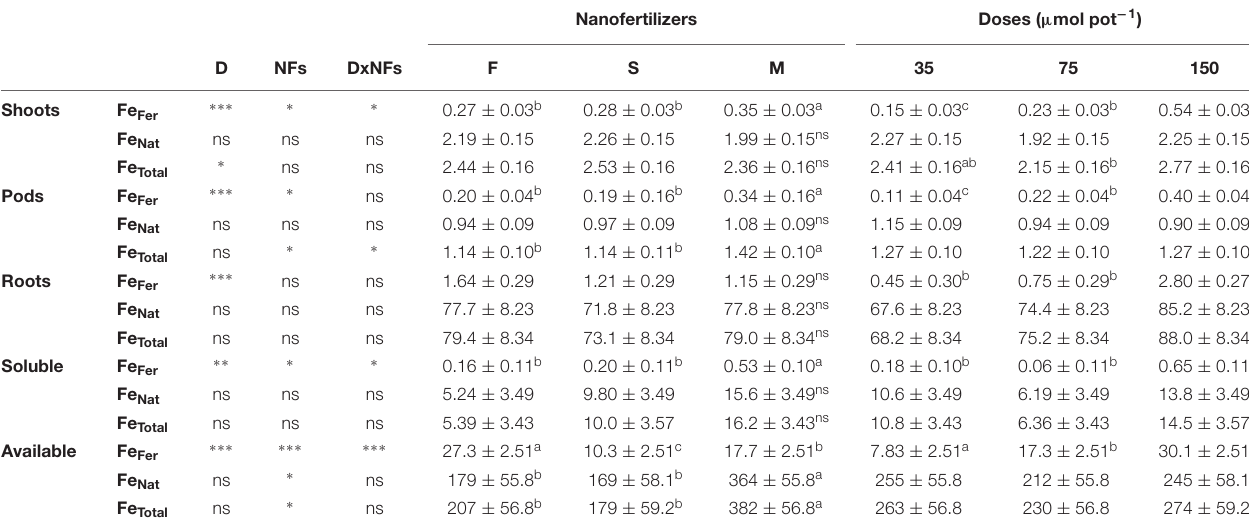
TABLE 4 | Effect of doses (D) and nanofertilizers (NFs) related to the contents of Fe Fer , Fe Nat , and Fe Total ( µ mol pot − 1 ) in soybean shoots, roots, pods, soluble and available soil fraction for soybean plants fertilized with the products F, S, and M with three doses (35, 75, and 150 µ mol pot − 1 ) at 48 DAF.